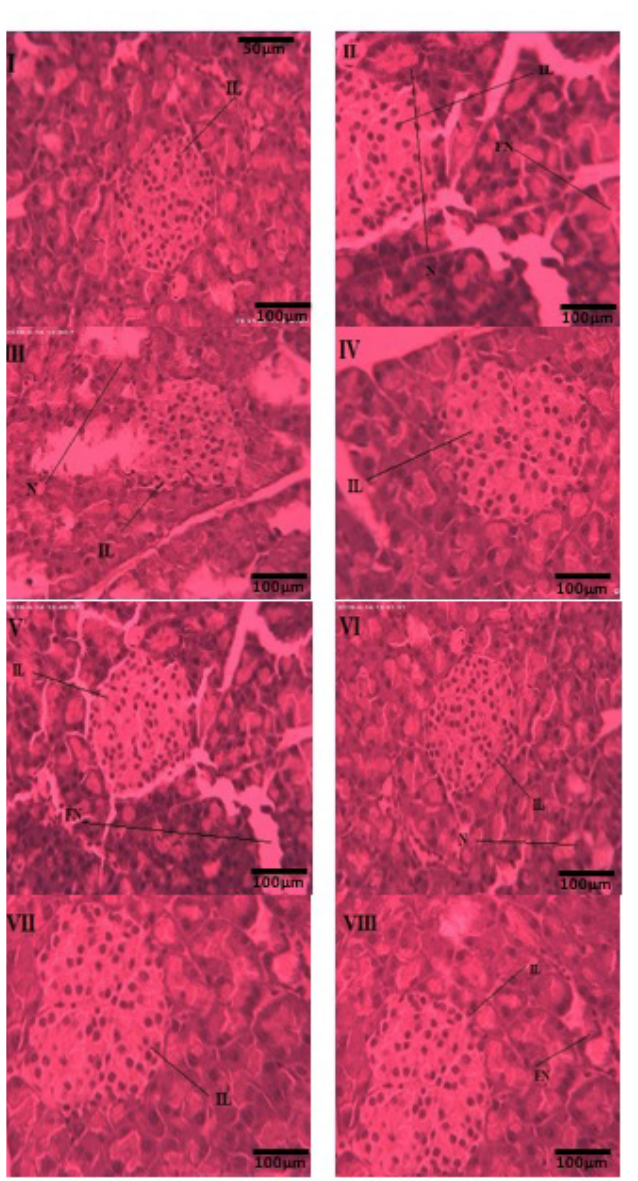
FIGURE 4 - Histology of the pancreas. (I) normal control, (II) diabetic control, (III) HNC, (IV) HNN, (V) HNE, (VI) HNA, (VII) lupeol and (VIII) glibenclamide. Samples were magnified at 40X and “IL” is Islet of Langerhans, “N” is necrosis and “FN” is focal necrosis.